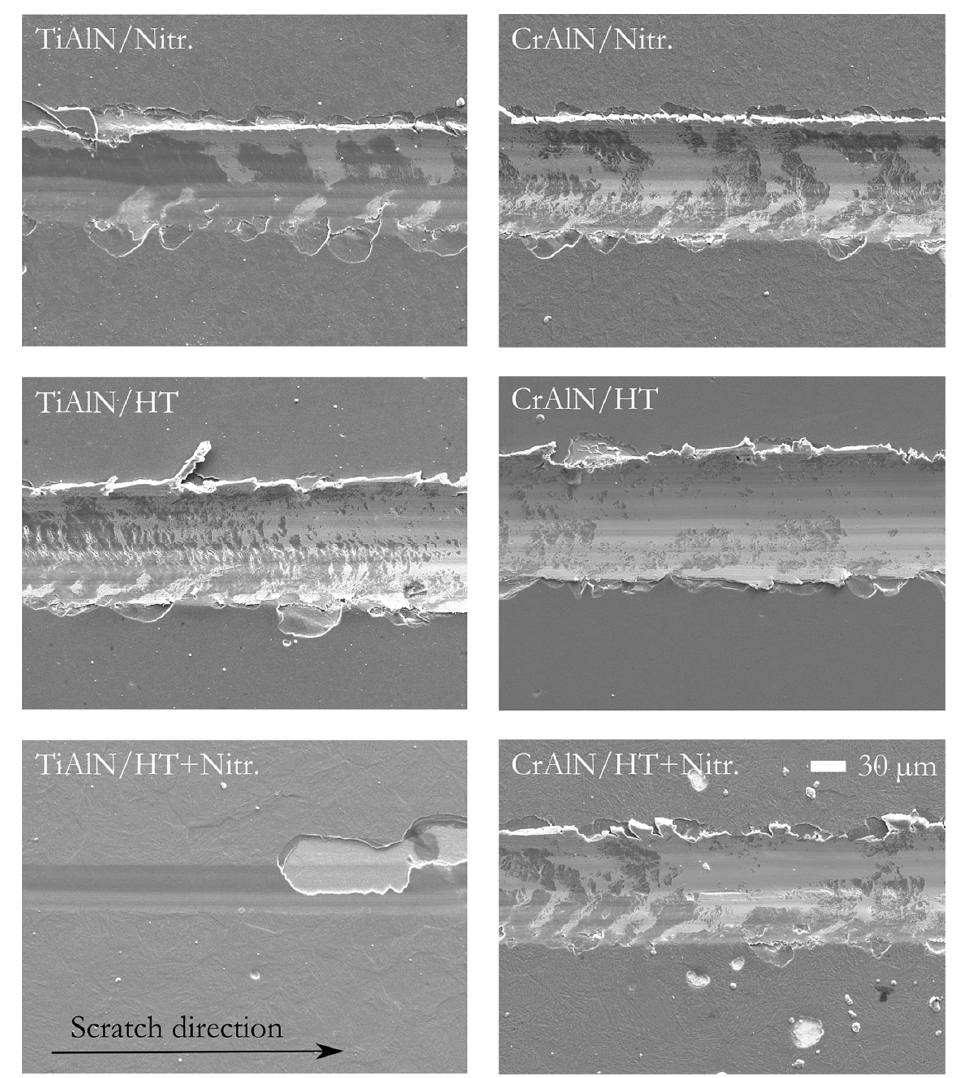
Figure 9. SEM micrographs of the scratches at the position of the critical load 3 (Lc 3 ) for each coating/substrate